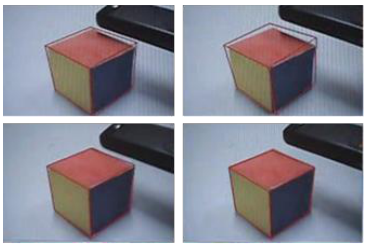
Figure 17. PS tracking precision for the synthetic sequence using SH and MH.